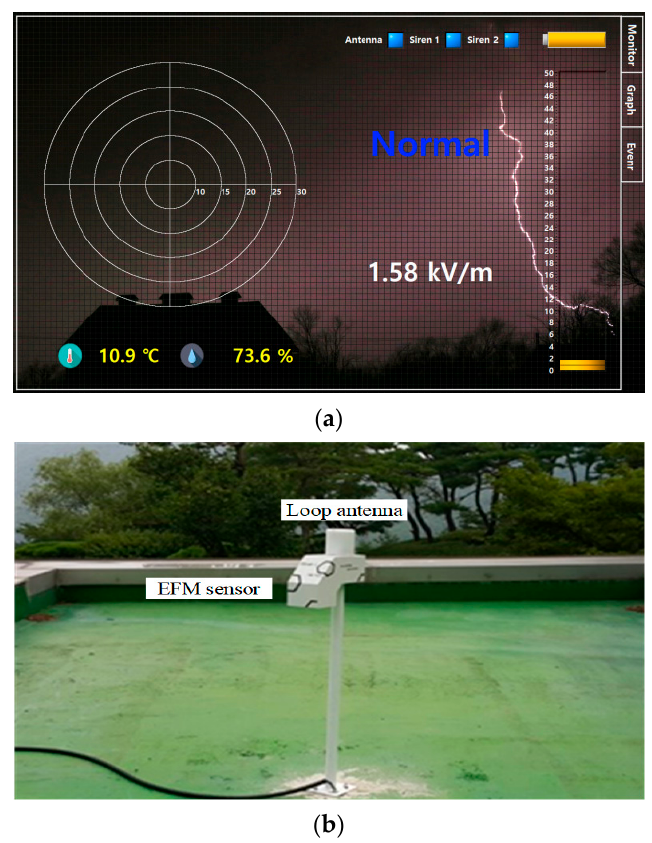
Figure 9. Lightning warning system. ( a ) Front panel; ( b ) installation.